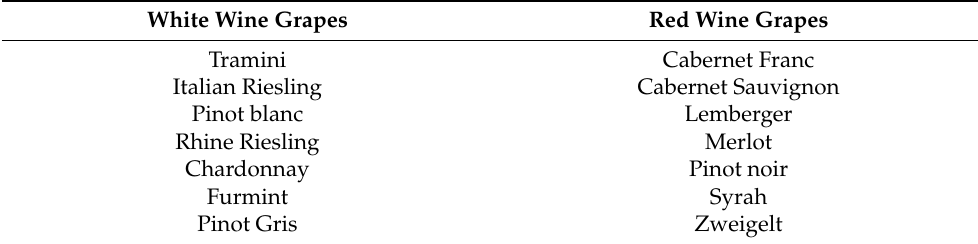
Table 2. TThe white and red wine grape varieties were included in the study. White Wine Grapes Red Wine Grapes Tramini Cabernet Franc Italian Riesling Cabernet Sauvignon Pinot blanc Lemberger Rhine Riesling Merlot Chardonnay Pinot noir Furmint Syrah Pinot Gris